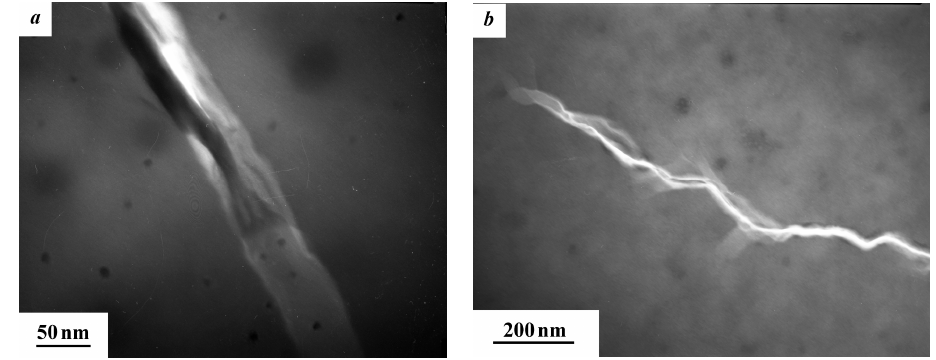
Figure 5. Shear bands in the composites formed from AA and subjected to HPT at N = 3 ( a ) and N = 5 ( b ).